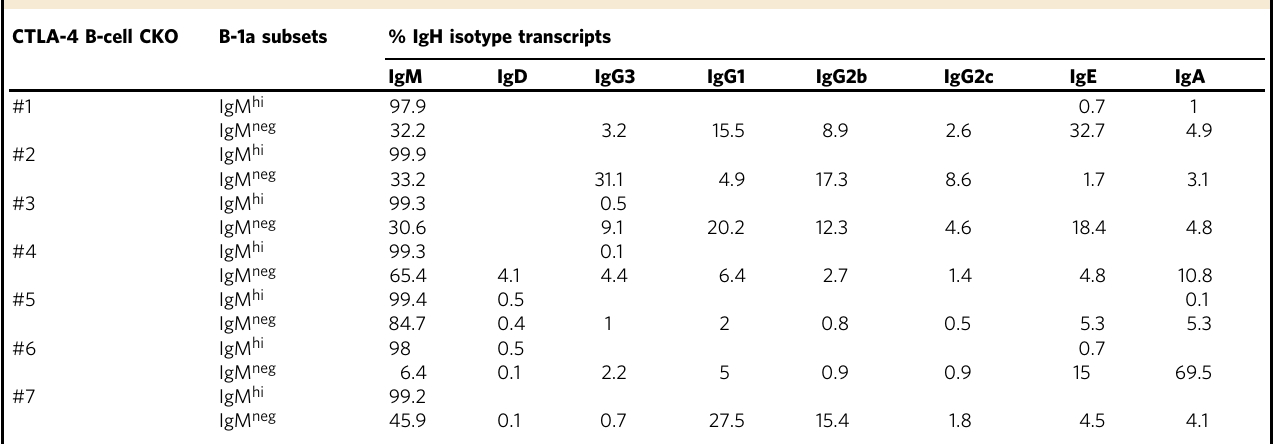
Table 1 IgH repertoire expressed by IgM neg B-1a cells in CKO mice contains class-switched IgH transcripts. CTLA-4 B-cell